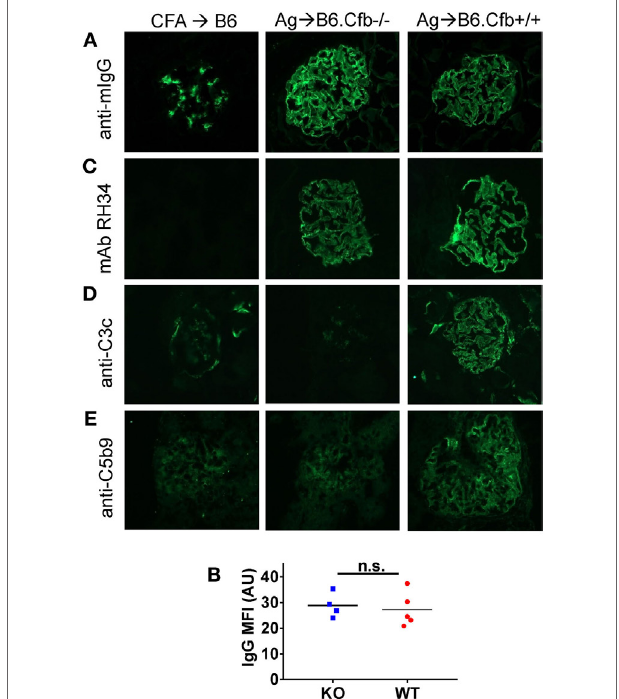
FigUre 6 | Analysis of glomerular immune complexes and complement deposition in B6 mice immunized with α 3NC1. Kidneys from adjuvant- immunized B6 mice (left), α 3NC1-immunized B6.Cfb − / − mice (middle), and